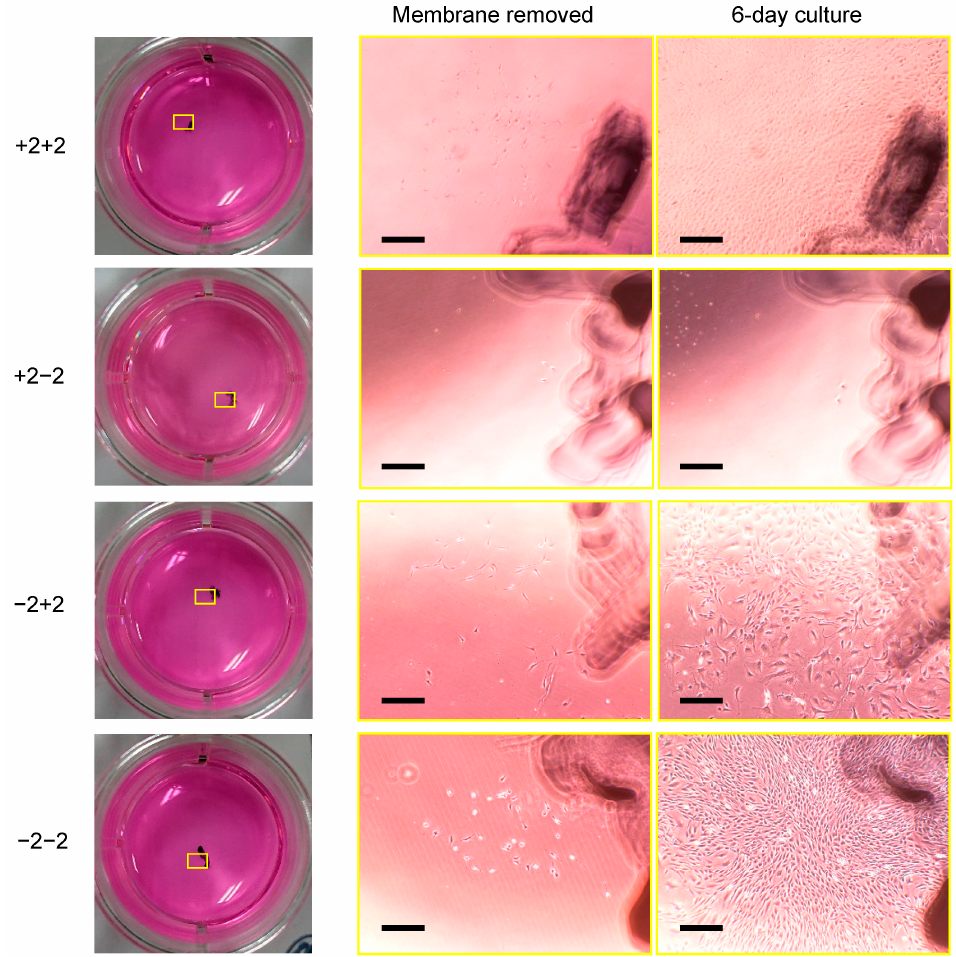
Figure 8. The outgrowth of C3H10T1/2 cells from the Ti membrane to a culture dish: following the second multi-layered culture, the top and bottom substrates were separately cultured in a new culture plate for 3 days. After removing the substrates, the cells migrating to the plate were cultured for 6 days. The selected areas (yellow boxes) in the new culture plate were compared between when the substrates were removed and when cells were cultured for 6 days (the scale bar represents 500 μ m).